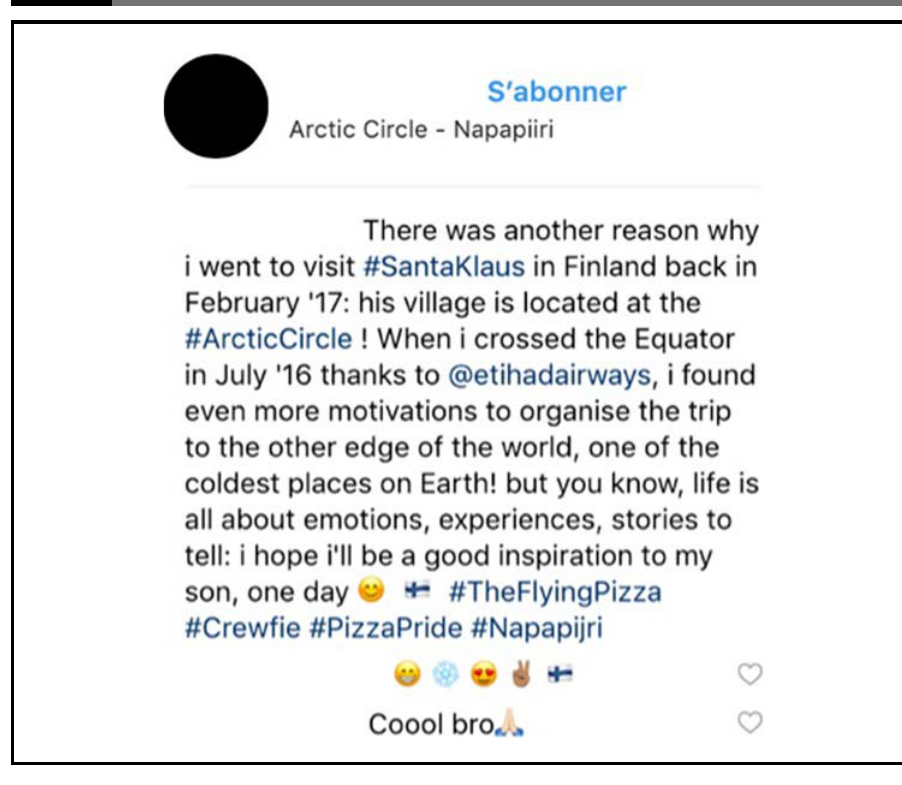
Figure 4 Crossing the Arctic Circle as a bucket list